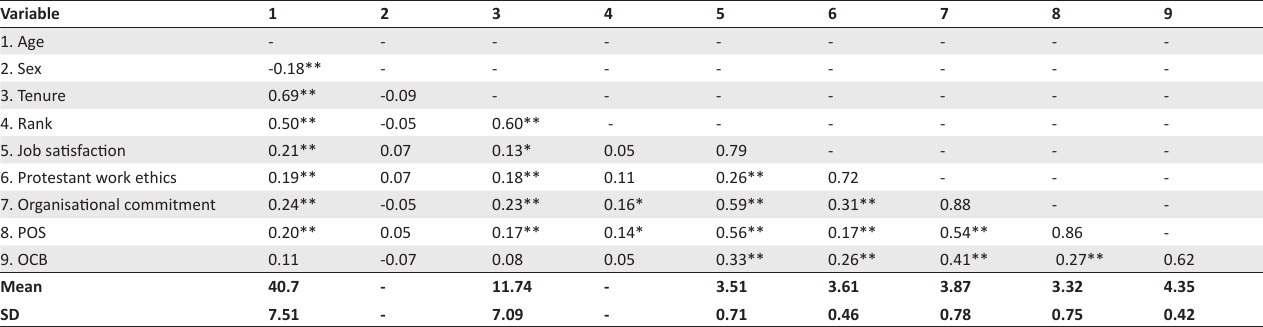
TABLE 1: Intercorrelation of variables, alpha coefficients and descriptive statistics.